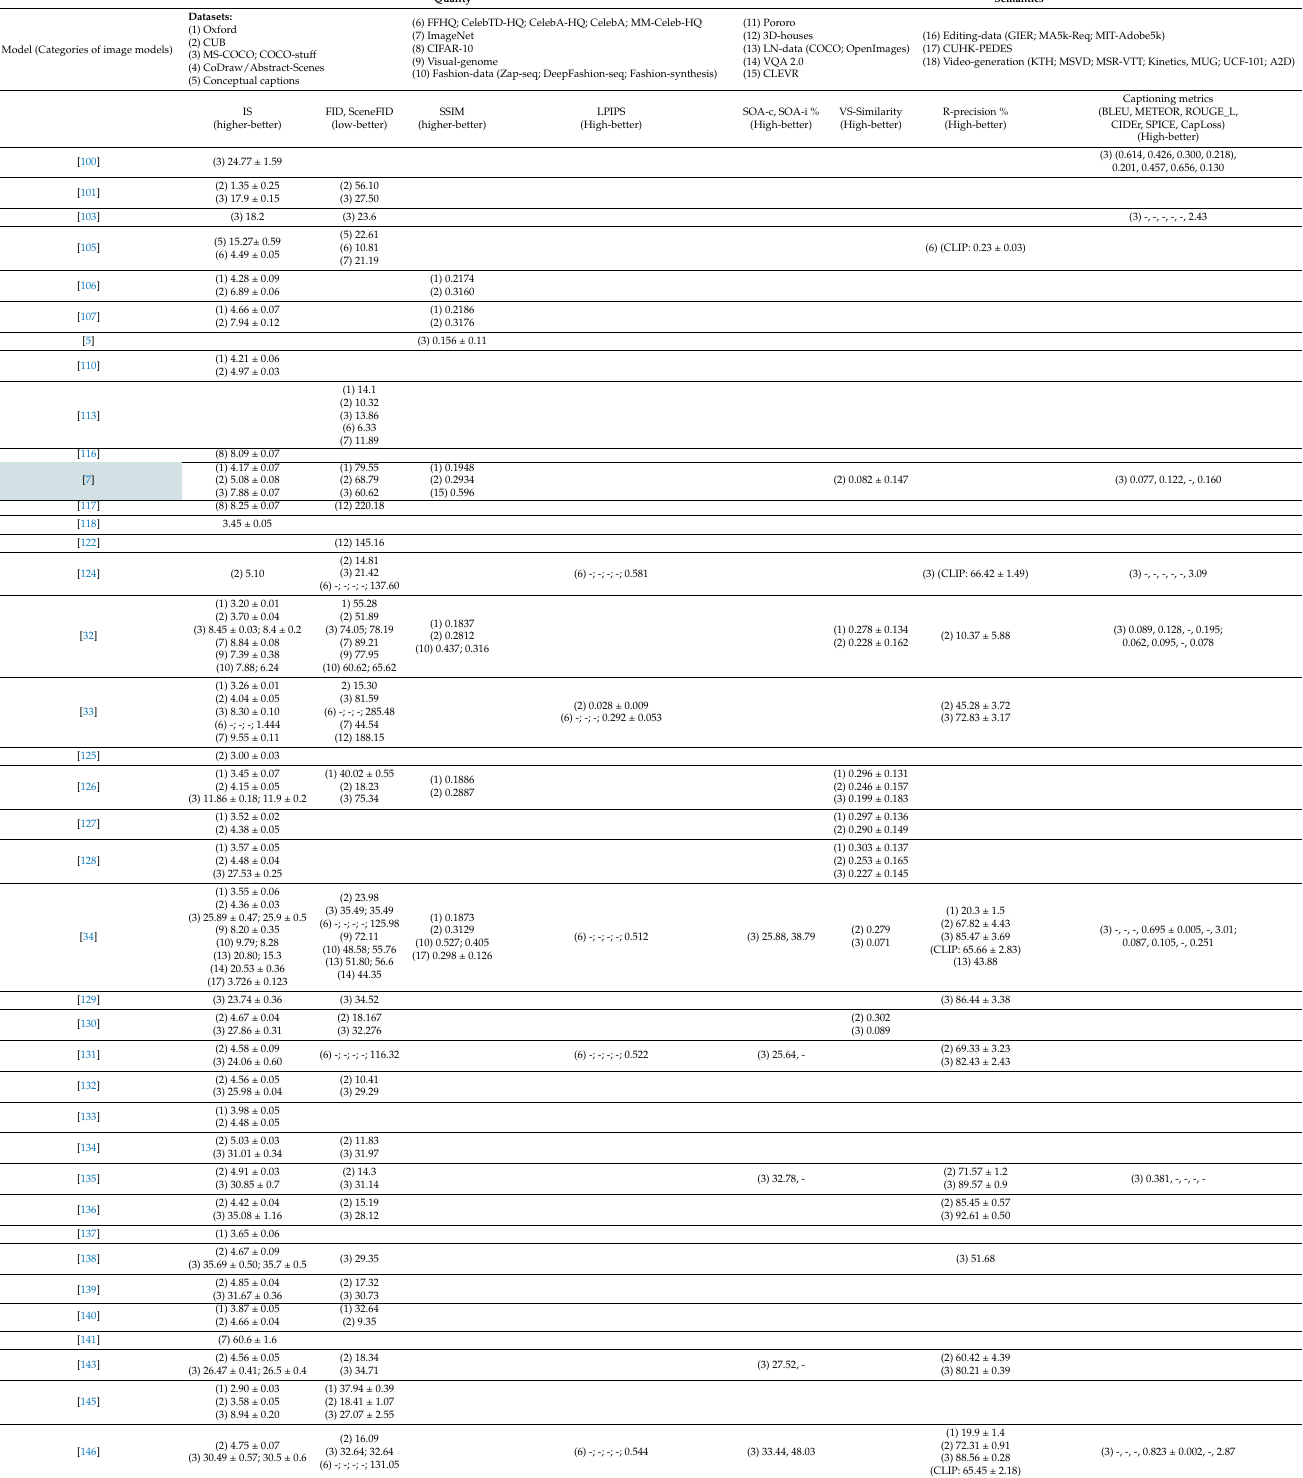
Table 4. Comparison of different image models based on the most-used evaluation metrics. Models marked in dark blue represent additional metrics not listed in the table, whereas light blue shows the models which do not give any of these metrics in their own paper. To efficiently compact the table, the symbol “;” separates the datasets within the same row, “-” for no data available, and “,” for